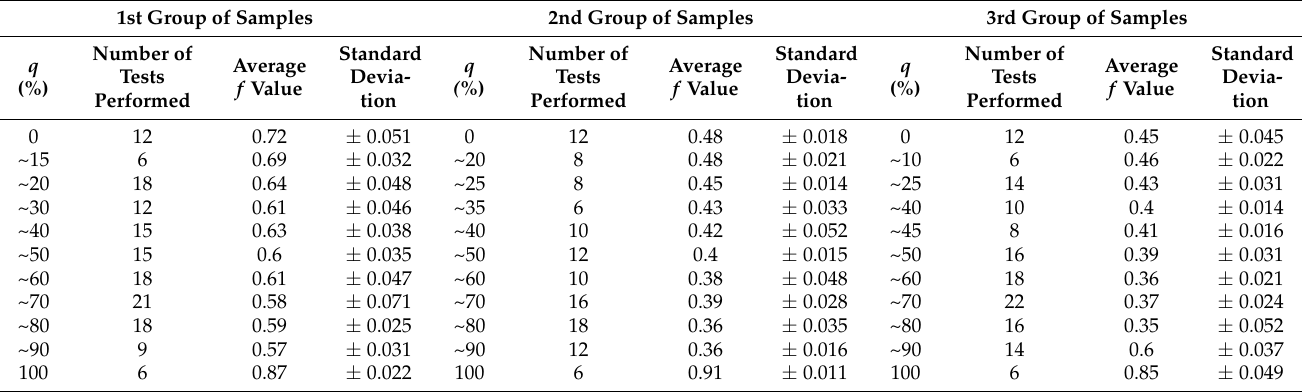
Figure 6. Dependence of the coefficient of friction f of brake pads from the degree of wear q : — first group; - - second group; - • - third group. Table 4. Test results of the coefficient of friction.